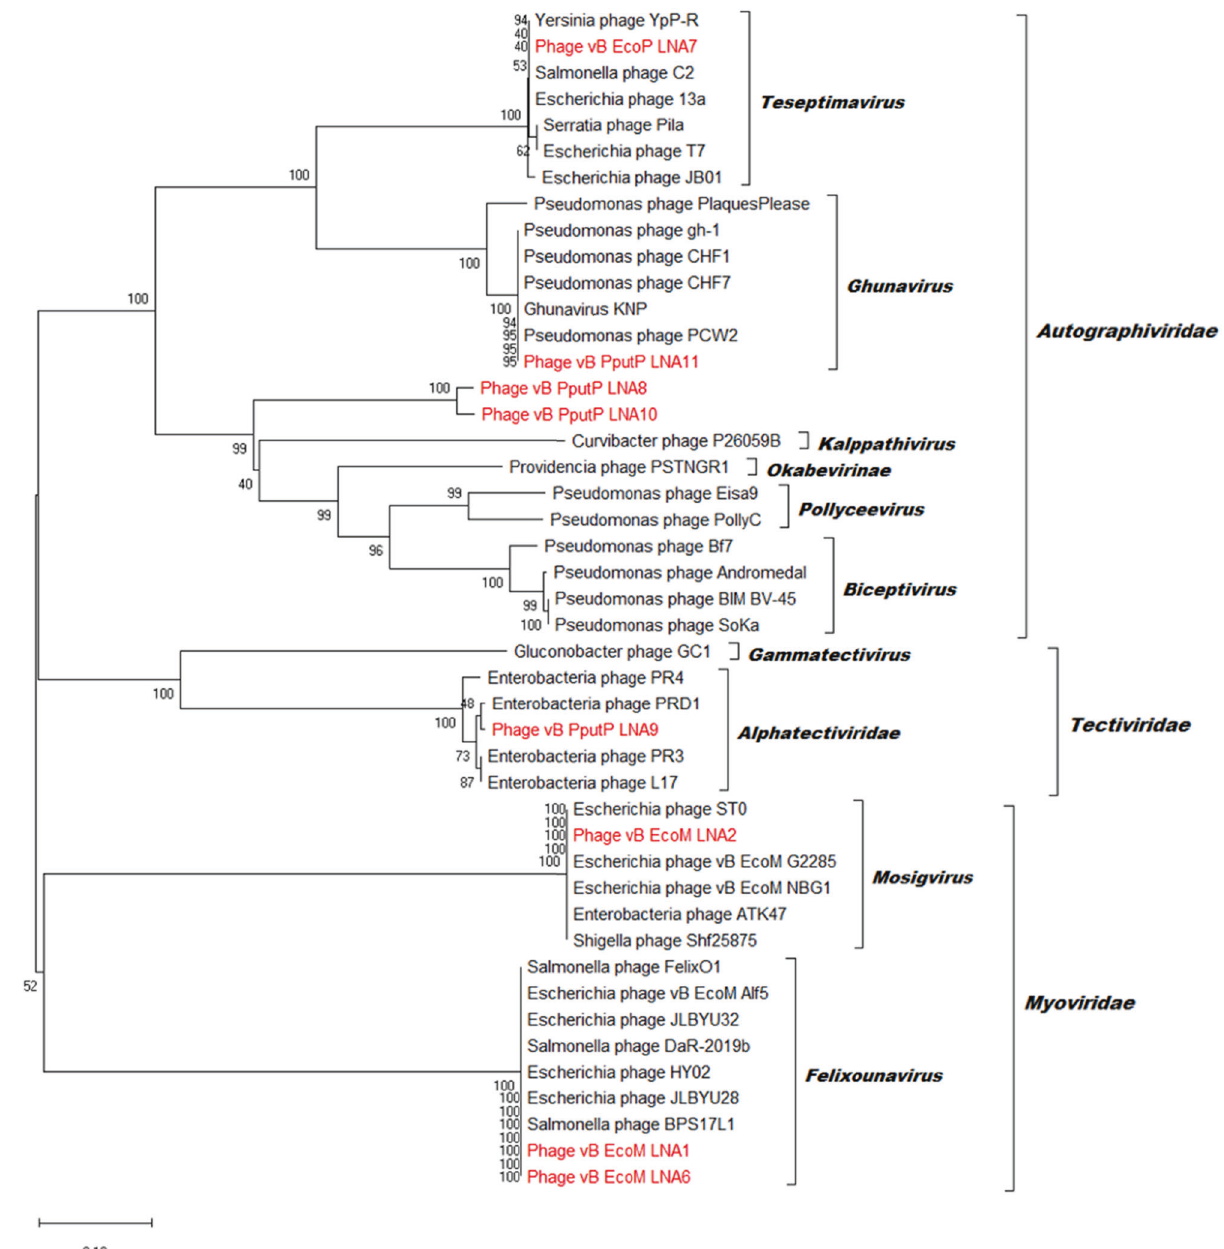
Fig. 3 Phage proteomic phylogenetic tree constructed using phage-encoded protein terminase large subunit. Phages isolated in this study is highlighted in red. The phylogenetic tree was generated using the neighbour joining method and 1000 bootstrap replicates. The number at each node represents the bootstrap values based on 1000 resampling. Scale bar indicates 0.2 amino acid substitution per residue. The taxonomic label of the phylogenetic tree was labelled (from left to right) at genus level classi fi cation and family level classi fi